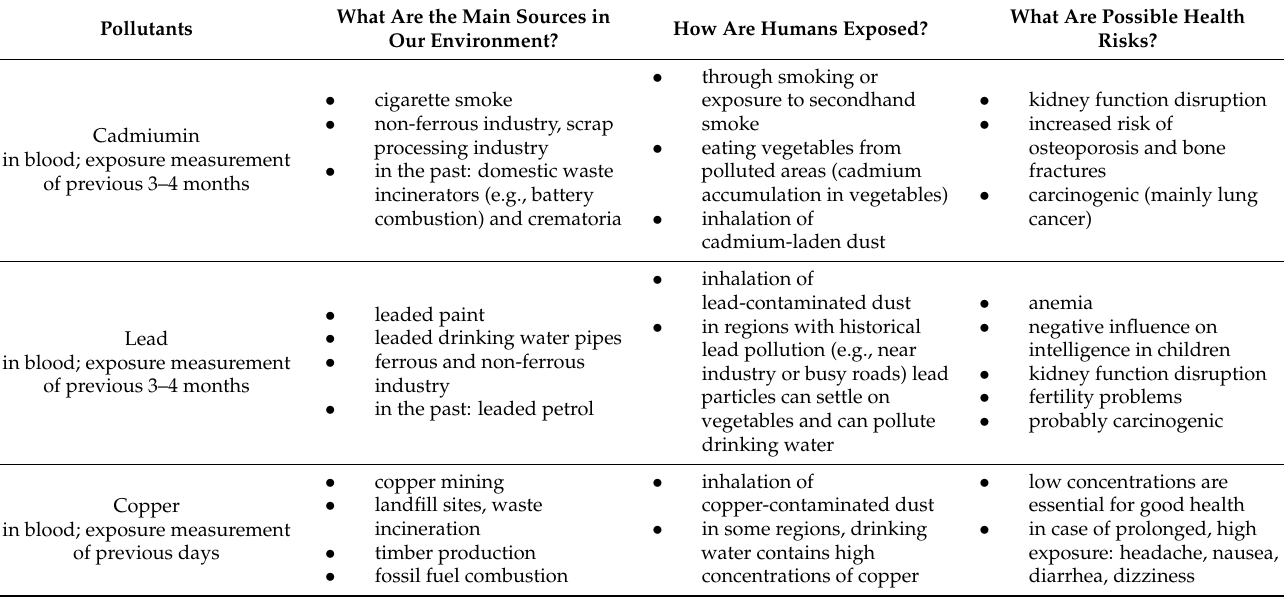
Table 2. Illustration of background information for individual report-back of HBM results, for three out of seventeen biomarkers (translated from Dutch)